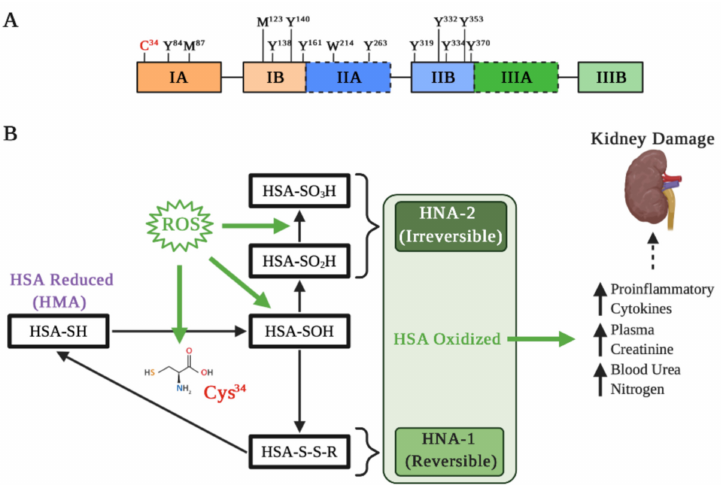
Figure 2. Albumin oxidation affects its properties in kidney damage. ( A ) Main residues on the active HSA sensitive to oxidation: Cys residue at position 34; Tyr residues 84, 138, 140, 161, 263, 319, 332, 334, 353, and 370; Met residues at positions 87 and 123; and Trp residue at position 214. Met-87 and Met-123 are most oxidized to methionine sulfoxide, particularly in kidney failure and diabetes. ( B ) Different types of Cys34 oxidation. Under oxidative stress induced by reactive oxygen species (ROS), albumin is oxidized and Cys34 forms a disulfide with a free cysteine or glutathione. The oxidation changes the HSA three-dimensional structure that influences binding of drugs, such as Sudlow’s site II. Depending on the extent of HSA oxidations, they can be classified as reversible (HNA-1) and irreversible (HNA-2), which may increase different pro-inflammatory cytokines and markers of kidney